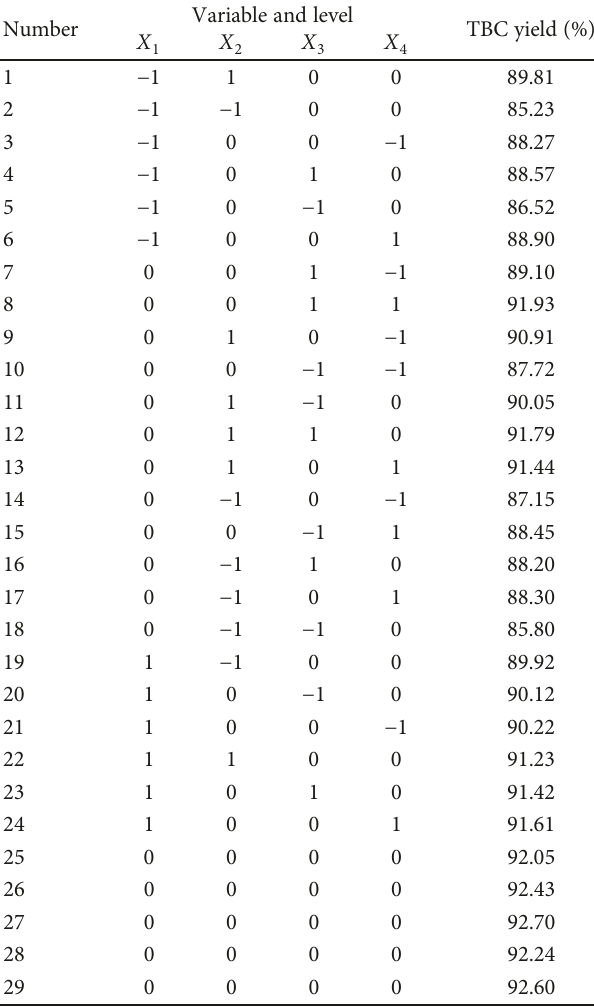
Table 4: Signi fi cance of the coe ffi cient and the corresponding statistical